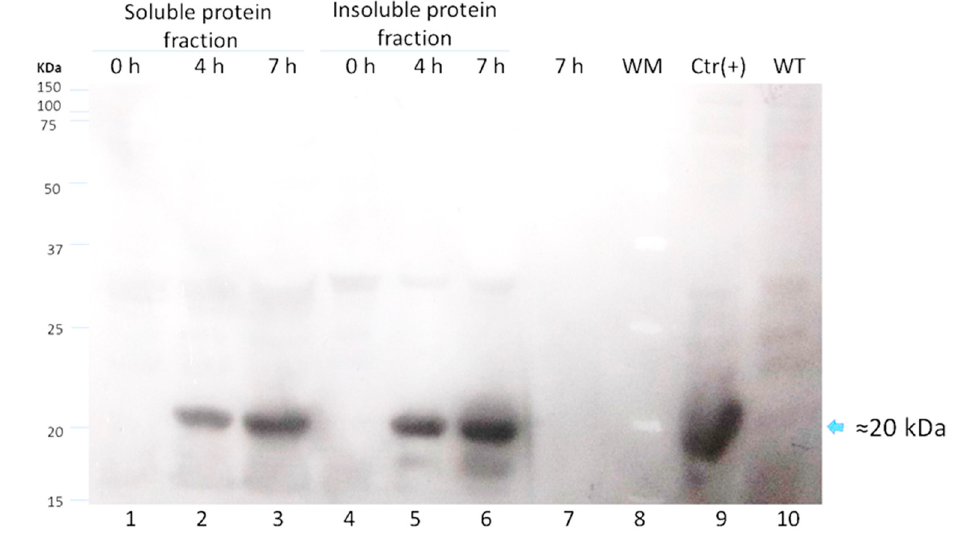
Figure 5. Western blot analysis for LTB-RBD Wuhan using anti-His tag of protein extracts from cultures induced for 4 or 7 h at 28 °C with lactose as inducer (lanes 1 to 3: soluble protein fraction and lanes 4 to 6: insoluble protein fraction). Lanes 1 and 4: uninduced cultures, lanes 2 and 5: cultures induced for 4 h, lanes 3 and 6: cultures induced for 7 h, lane 7: culture medium supernatant, lane 8: molecular weight marker, lane 9: RBD protein as positive control, and lane 10: soluble fraction of an untransformed culture.